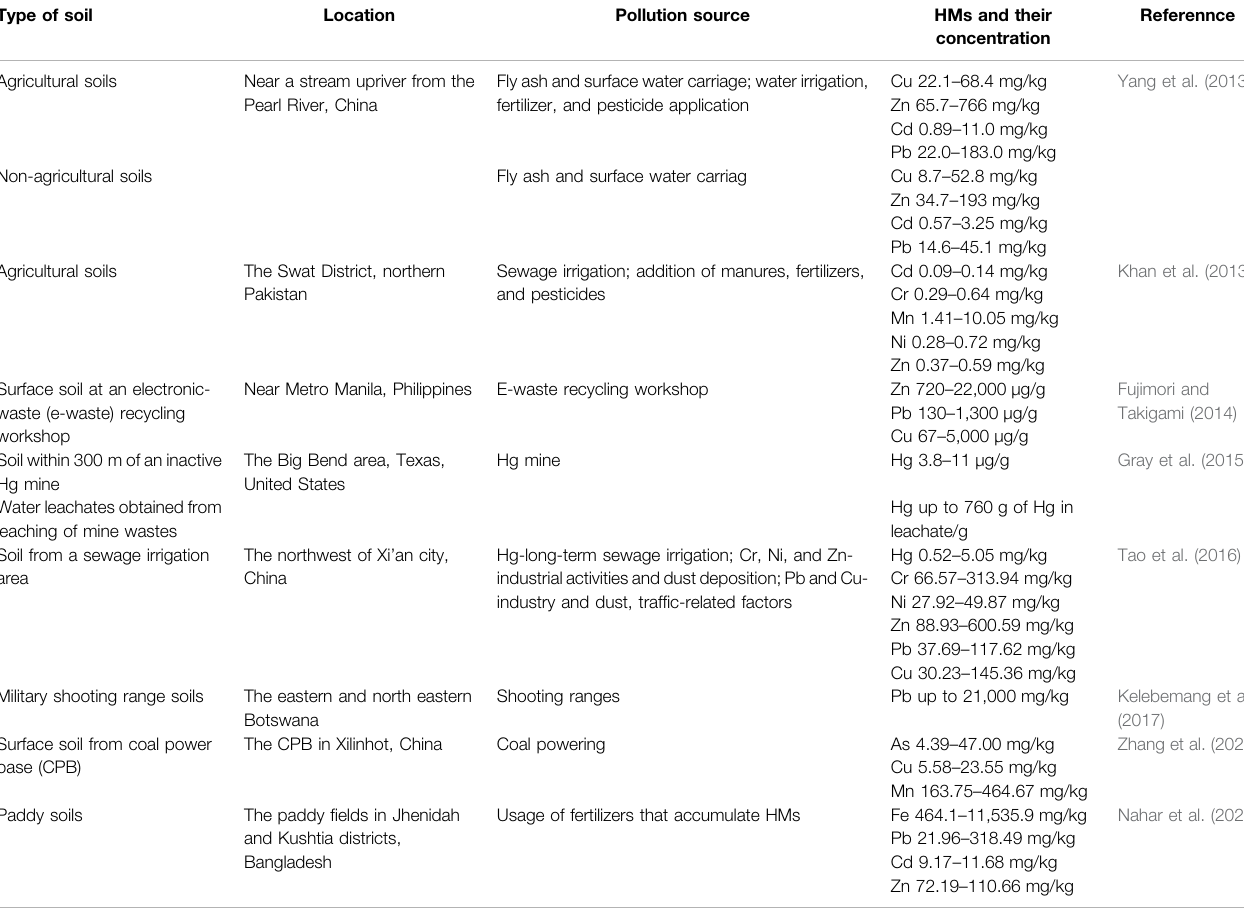
TABLE 3 | Source and concentration of HMs in